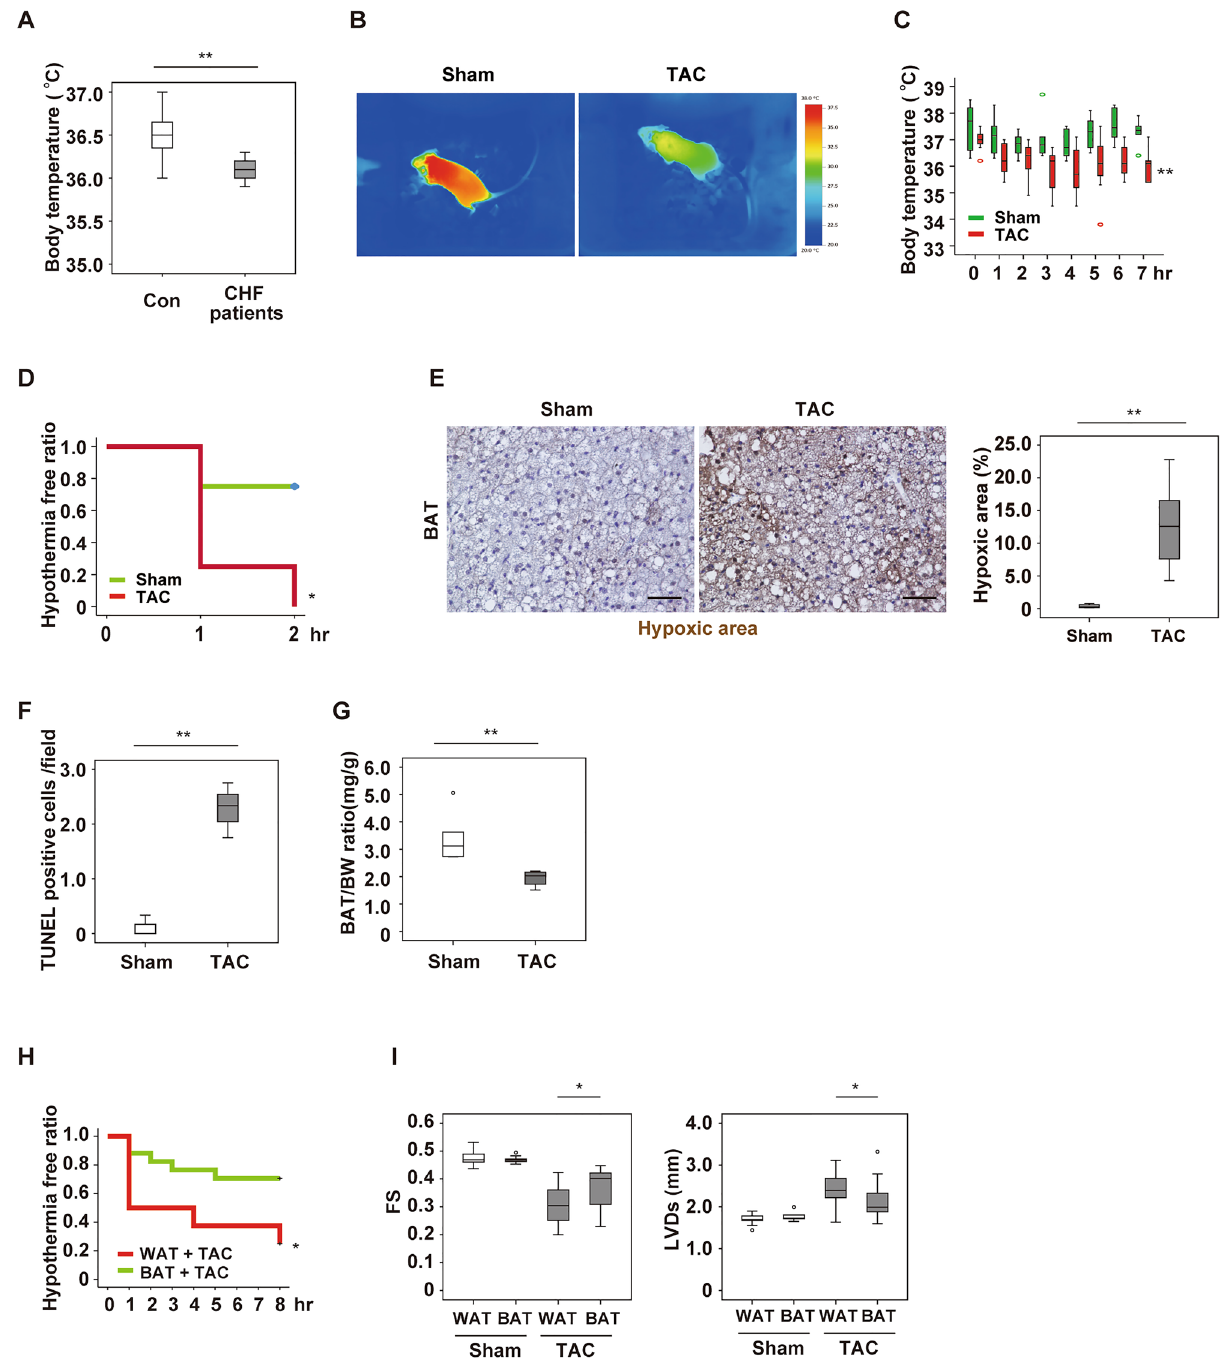
Figure 1. Left ventricular pressure overload induces dysfunction of brown adipose tissue. ( A ) Body temperature of control (Con) subjects and patients with congestive heart failure (CHF) ( n = 15, 9). ( B ) Surface body temperature measured by a thermal camera in mice at 5 weeks after sham surgery (Sham) or TAC. ( C ) Acute cold tolerance test performed in mice at 4 weeks after Sham or TAC with measurement of body temperature in the scapular region ( n = 6 and 7, respectively). ( D ) Hypothermia-free ratio during the acute cold tolerance test in mice at 4 weeks after Sham or TAC with measurement of the intraperitoneal temperature ( n = 4, 4). ( E ) Pimonidazole staining of BAT in mice from ( C ) performed by the Hypoxyprobe-1 method. The right panel shows quantification of the hypoxic area ( n = 4, 8). Scale bar = 50 μm. ( F ) Quantification of TUNEL-positive cells in BAT from mice at 6 weeks after Sham or TAC ( n = 3, 3). ( G ) Body weight (BW)-adjusted BAT weight in mice prepared as described in Fig. 1C ( n = 5, 4). ( H ) Hypothermia- free ratio during the acute cold tolerance test in mice with WAT or BAT transplantation at 2 weeks after TAC ( n = 11, 17). ( I ) Assessment of cardiac function in mice with WAT or BAT transplantation at 2 weeks after Sham or TAC. FS: fractional shortening ( n = 10, 11, 9, 19), LVDs: left-ventricular systolic dimension ( n = 10, 11, 9, 19). Data were analysed by the 2-tailed Student’s t-test ( A , E , F , G and I ), repeated measures followed by Tukey’s multiple comparison test ( C ), or the log-rank test for Kaplan–Meier method ( D , H ). *P < 0.05, **P < 0.01. Values are shown as the mean ±